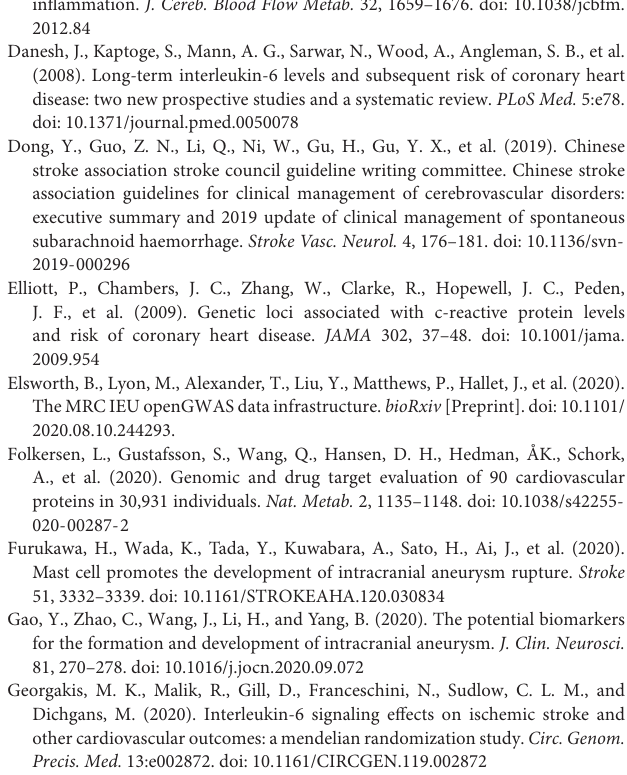
Supplementary Figure 3 | Leave-one-out sensitivity analysis of sIL6R on IA risk. Supplementary Figure 4 | Scatter plots of SNP-IL6R and SNP-IA associations. Supplementary Figure 5 | Forest plot of the estimate of CRP on IA risk. Supplementary Figure 6 | Leave-one-out sensitivity analysis of CRP on IA risk. Supplementary Figure 7 | Scatter plots of SNP-CRP and SNP-IA associations. Supplementary Table 1 | Characteristics of sIL6R-associated SNPs. Supplementary Table 2 | Characteristics of CRP-associated SNPs.